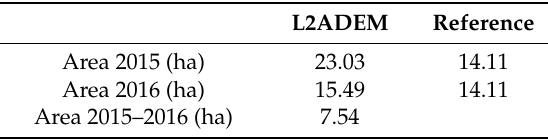
Figure 14. Treefall gap fuzziness map evaluated from 2016 at the BS on a 10 m resolution grid ( a ). Regeneration strength map of partial crown damage between 2015 and 2016 on the same 10 m resolution grid ( b ). Table 13. Evaluated area from time series on